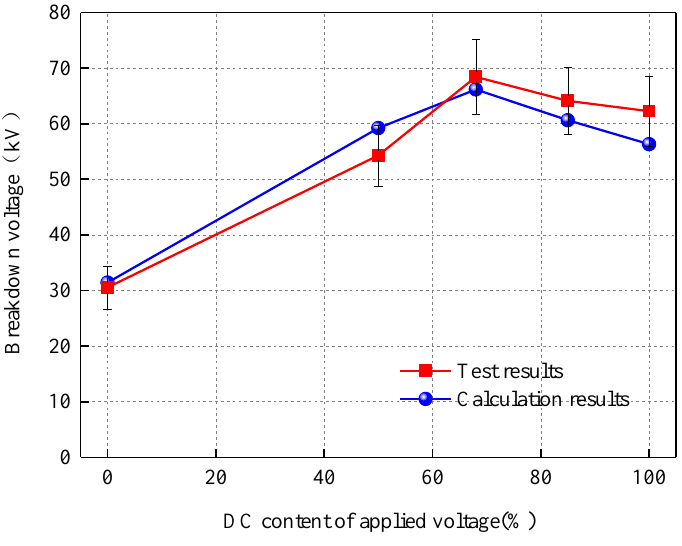
Figure 13. Comparison of test and calculation results of oil-pressboard insulation breakdown.